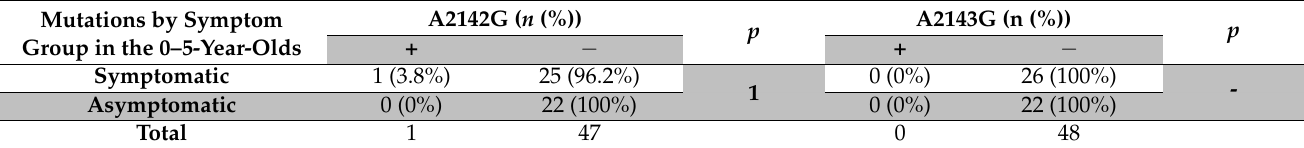
Table 6. The distribution of A2142G and A2143G mutations by symptom group in the 0–5-year-olds.